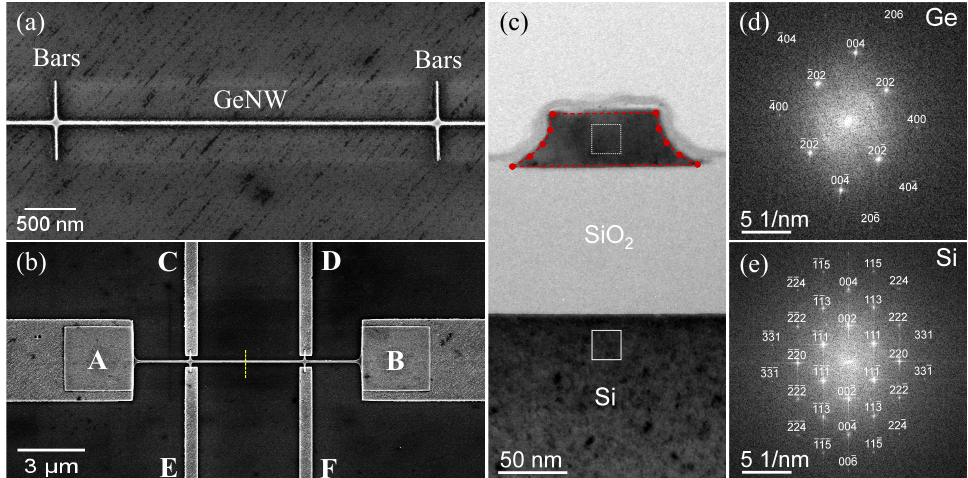
Figure 2. ( a ) Top-view SEM image of a 33 nm wide GeNW with narrow Ge bars; ( b ) top-view SEM image of the fabricated device with the six-contact Hall bar configuration after metal deposition. The contacts are labeled with A–F. ( c ) Cross-sectional BF-TEM image obtained from the NW location indi- cated in panel ( b ) by a yellow dashed line, the red dashed curve shows the cross-section considered for the simulation. ( d , e ) Fast Fourier transforms of HR-TEM images (not shown) from the Ge and Si region marked with a white dotted and solid square in panel ( c ), respectively. While the BF-TEM image and the Si HR-TEM image were obtained in Si [ 1 1 0 ] zone axis geometry (the corresponding diffractogram is indexed in panel ( e )), the Ge HR-TEM image was recorded in Ge [ 0 1 0 ] zone axis geometry (the corresponding diffractogram is indexed in panel ( d